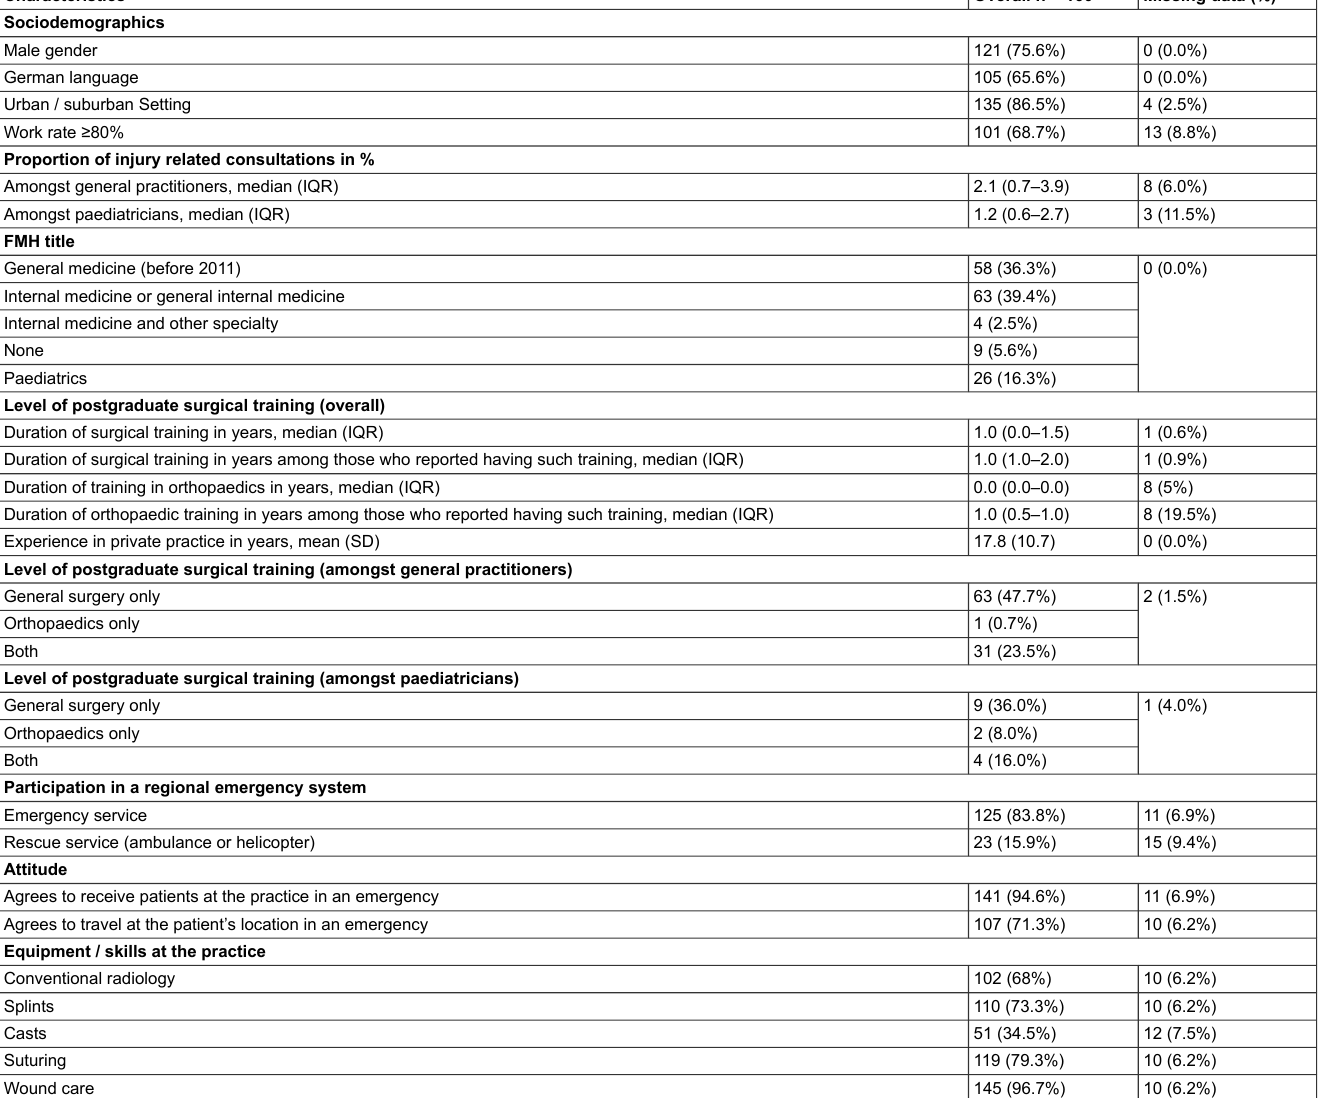
Table 1: Characteristics of the physician population of the study (Total n = 160).